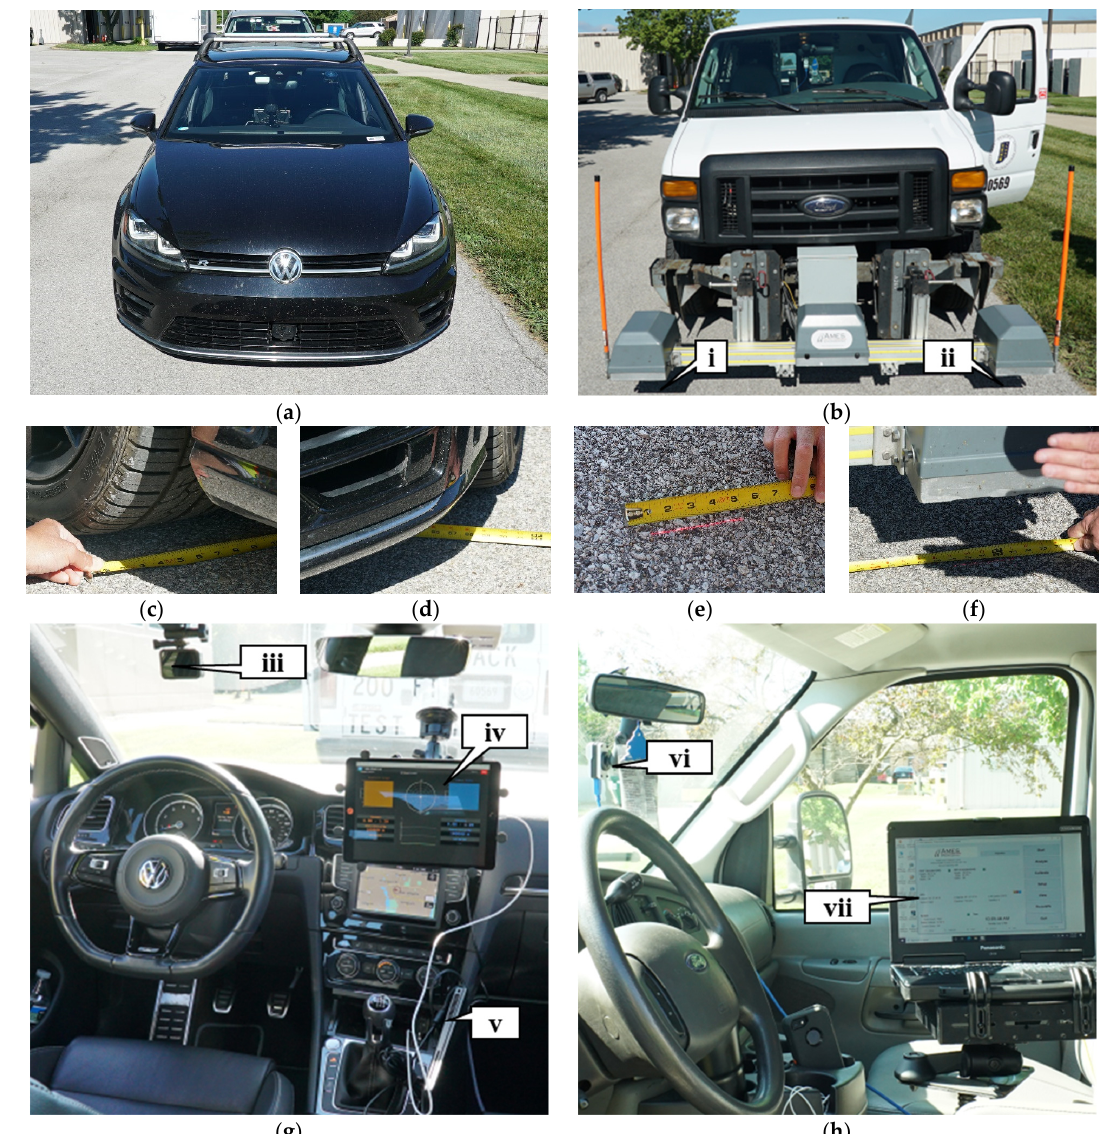
Figure 4. Production vehicle and profiler data collection equipment: ( a ) production vehicle; ( b ) in- ertial profiler; ( c ) production vehicle track width (passenger side); ( d ) production vehicle track width (driver side); ( e ) profiler laser width (passenger side); ( f ) profiler laser width (driver side); ( g ) interior of production vehicle; ( h ) interior of inertial profiler. Callout (i) laser scanner (passenger side); (ii) laser scanner (driver side); (iii) GoPro camera in production vehicle; (iv) user interface (production vehicle); (v) laptop data logger; (vi) dash camera (inertial profiler); (vii) user interface (inertial profiler).